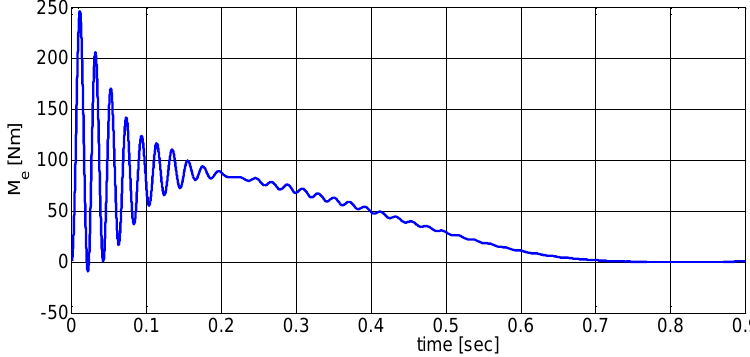
Figure 9. Electromagnetic torque waveform of a solid-rotor induction motor.